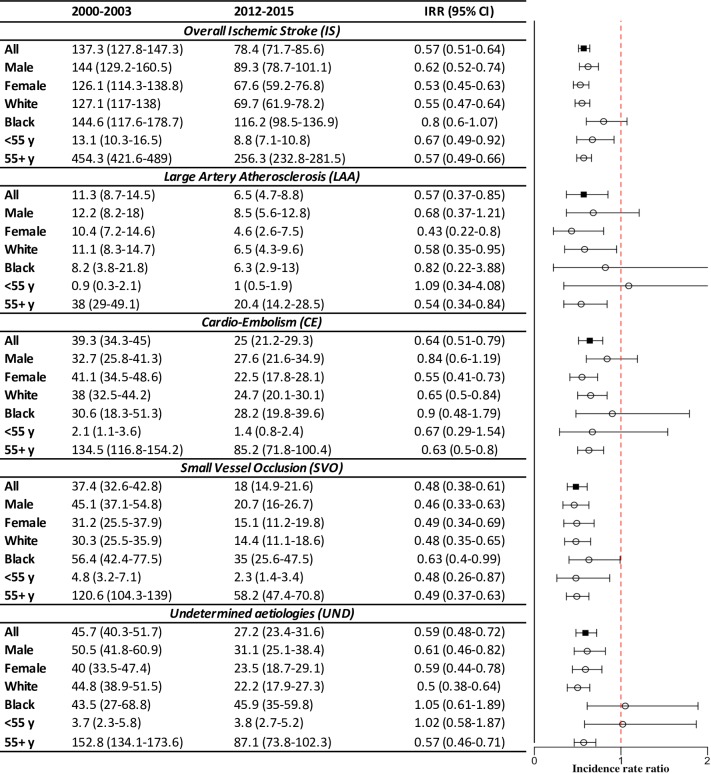
Standardised† annual incidences per 100,000 per year (95% CI) of first ISs over time, stratified by sex, ethnicity, and age groups.† To the 2011 census population of England and Wales. Complete information for other periods is available in Table C in S1 Appendix. IRR, incidence rate ratio; IS, ischaemic stroke.